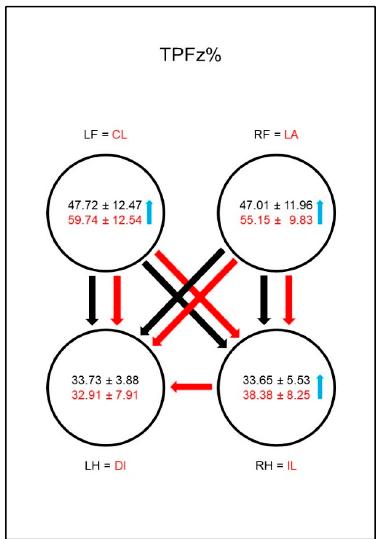
Figure 13. Time to PFz as a percentage of stance phase duration (TPFz%) in study group 2 and control group. For detailed explanation and abbreviations refer to Figure 2.